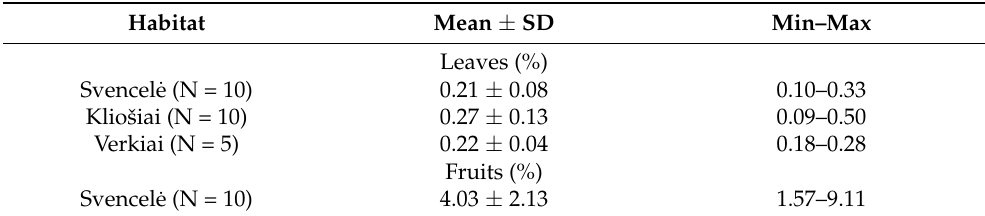
Table 1. Percentages of essential oil in the leaves and fruits of the Myrica gale growing in different habitats. CV — coefficient of variation.